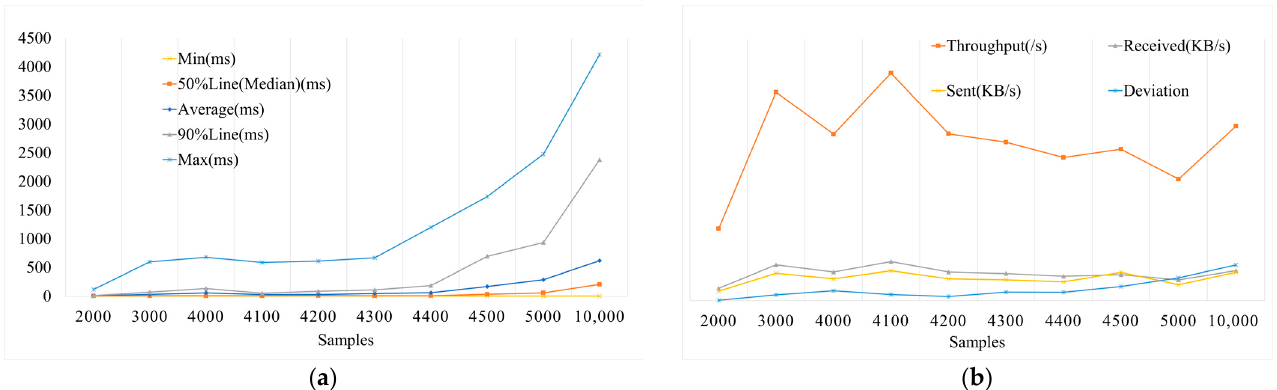
Figure 10. Statistics of system response.